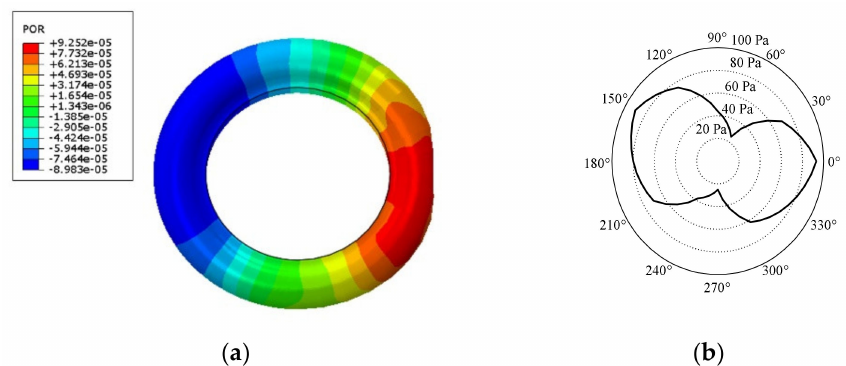
Figure 17. Distribution of the acoustic pressure amplitude for the running speed of 60 km/h: ( a ) Distributions contour of the acoustic pressure amplitude; ( b ) Distributions of the acoustic pressure amplitude in the polar coordinate system.